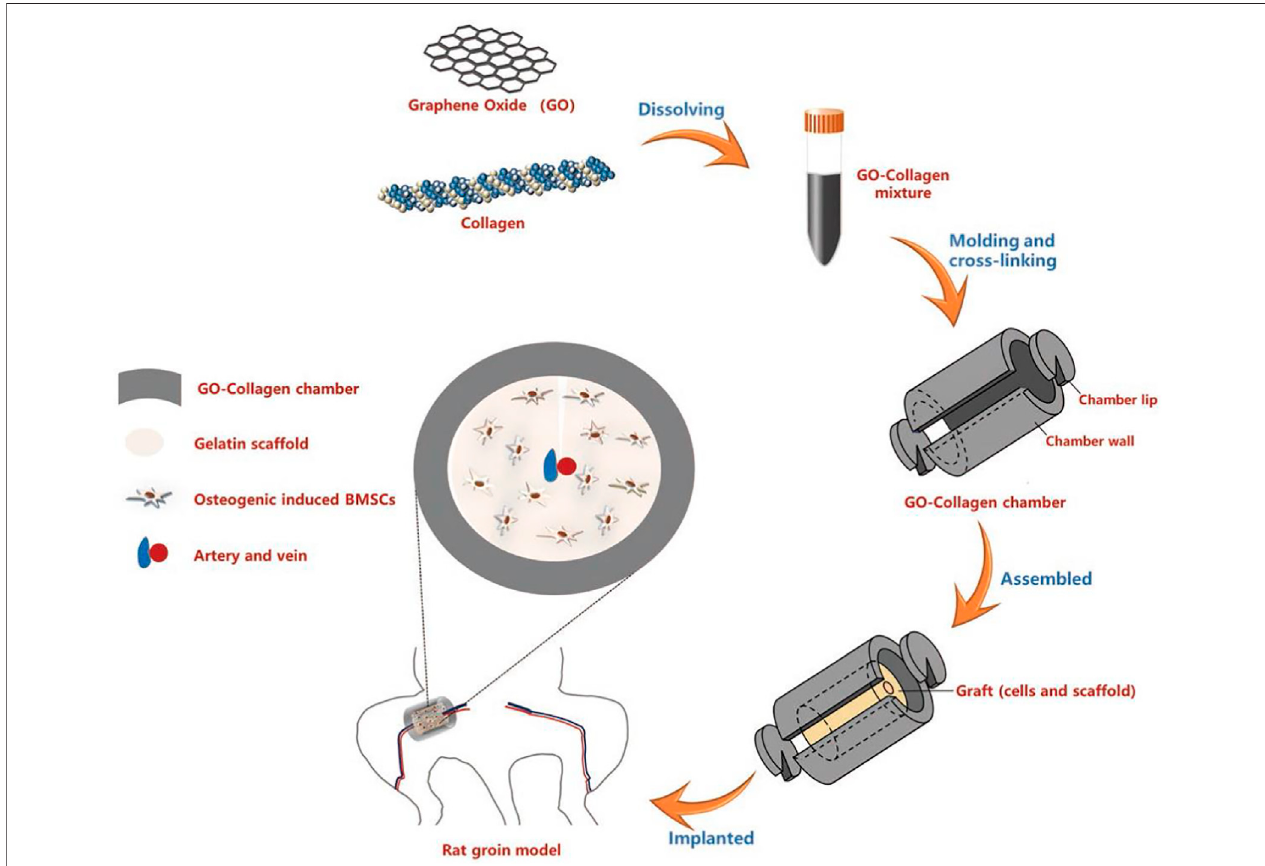
FIGURE 3 | Schematic illustration of the preparation and in vivo application of the GO-collagen tissue engineering chamber in a rat groin model. GO and collagen were dissolved, blended and injected into molds to obtain GO-collagen scaffolds with disc shape and hollow cylindrical shape. After the cross-linking process, GO- collagenscaffoldswerefabricatedtomakeatissueengineeringchamber.Then,theBMSCs-gelatingraftswereencasedintheGO-collagenchamberandimplantedinto the rat groin area, with vessels traversing through the graft. Reproduced from Fang et al. (2020) with permission from Copyright 2020 Ivyspring International